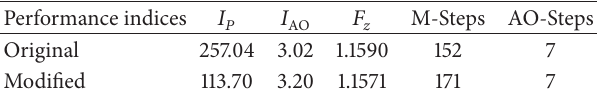
Table 3: Five performance indices from the 10% FP step load decrease simulation of the original and modified power control sys- tem in